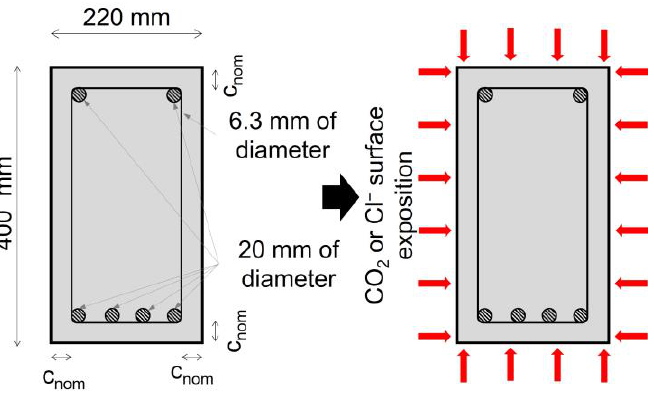
Figure 3. Dimensions of beams cross section (in mm) and surface exposure conditions.